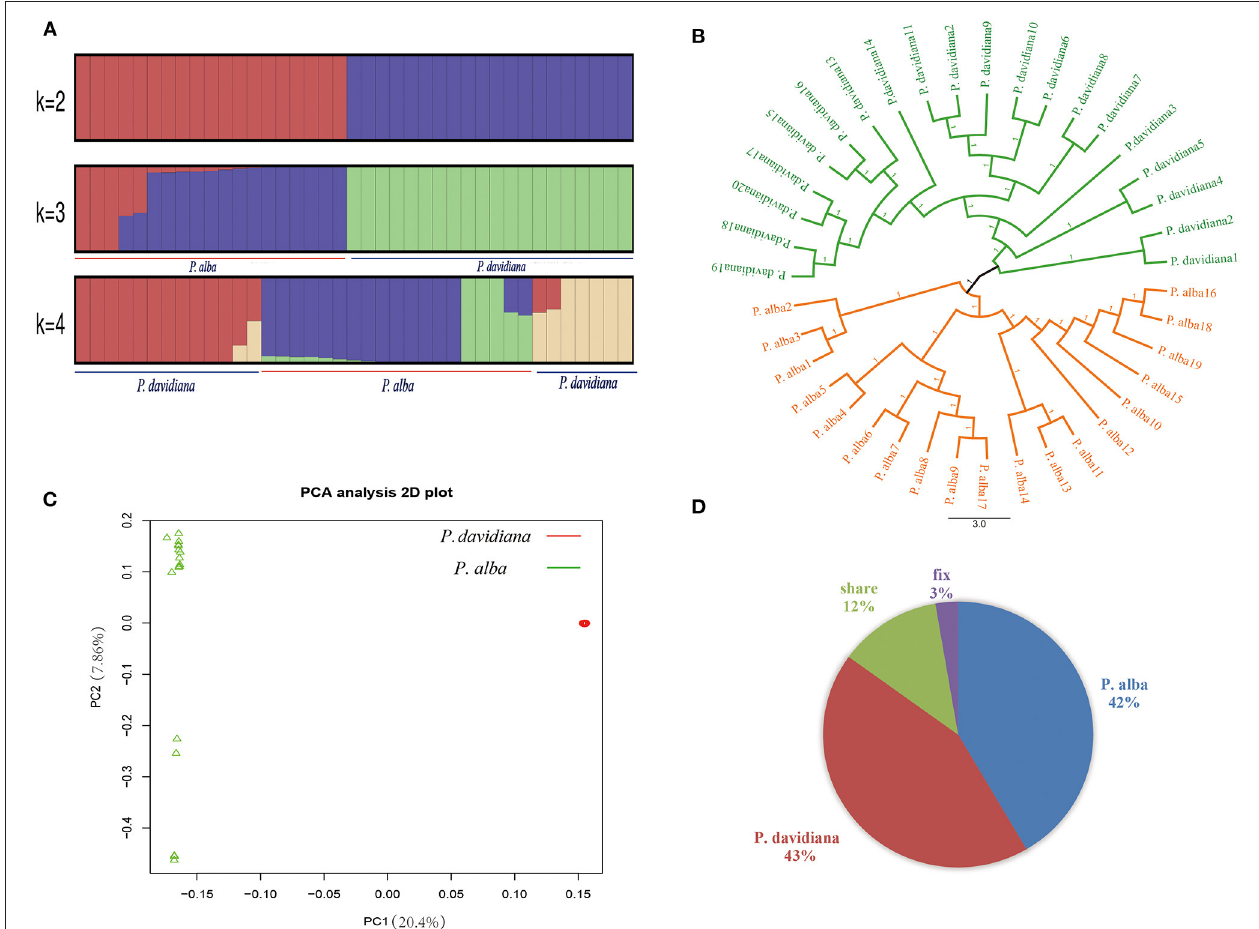
FIGURE 1 | Genetic structure of 20 Populus davidiana and 19 Populus alba . (A) Genetic structure of P. davidiana and P. alba inferred using NGSadmix. (B) A rooted neighbor-joining tree constructed from the allele-shared matrix of SNPs among the P. davidiana and P. alba . (C) Principal component analysis (PCA) plot based on genetic covariance. (D) Pie chart summarizing the proportion of fixed, shared and exclusive polymorphisms of the two